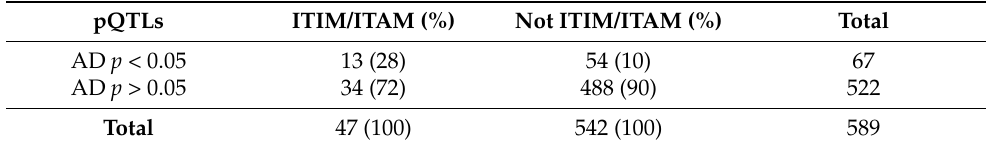
Table 2. Overlap of pQTL and AD